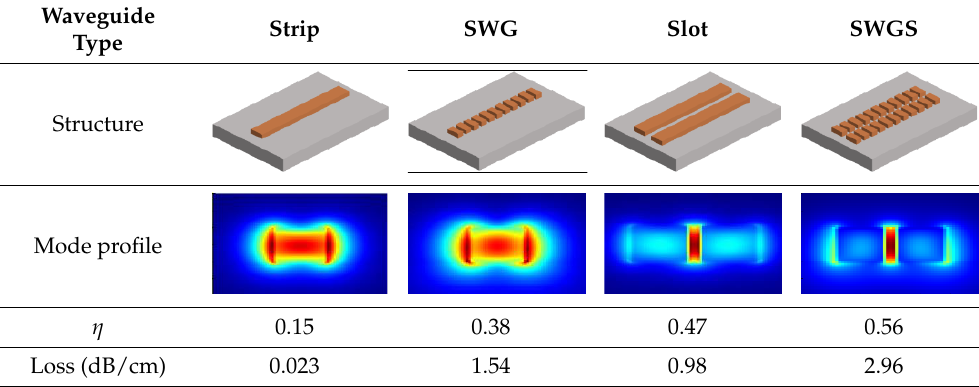
Table 1. Electric field distribution, calculated η and propagation loss for strip waveguide, SWG waveguide, slot waveguide, and SWGS waveguide.